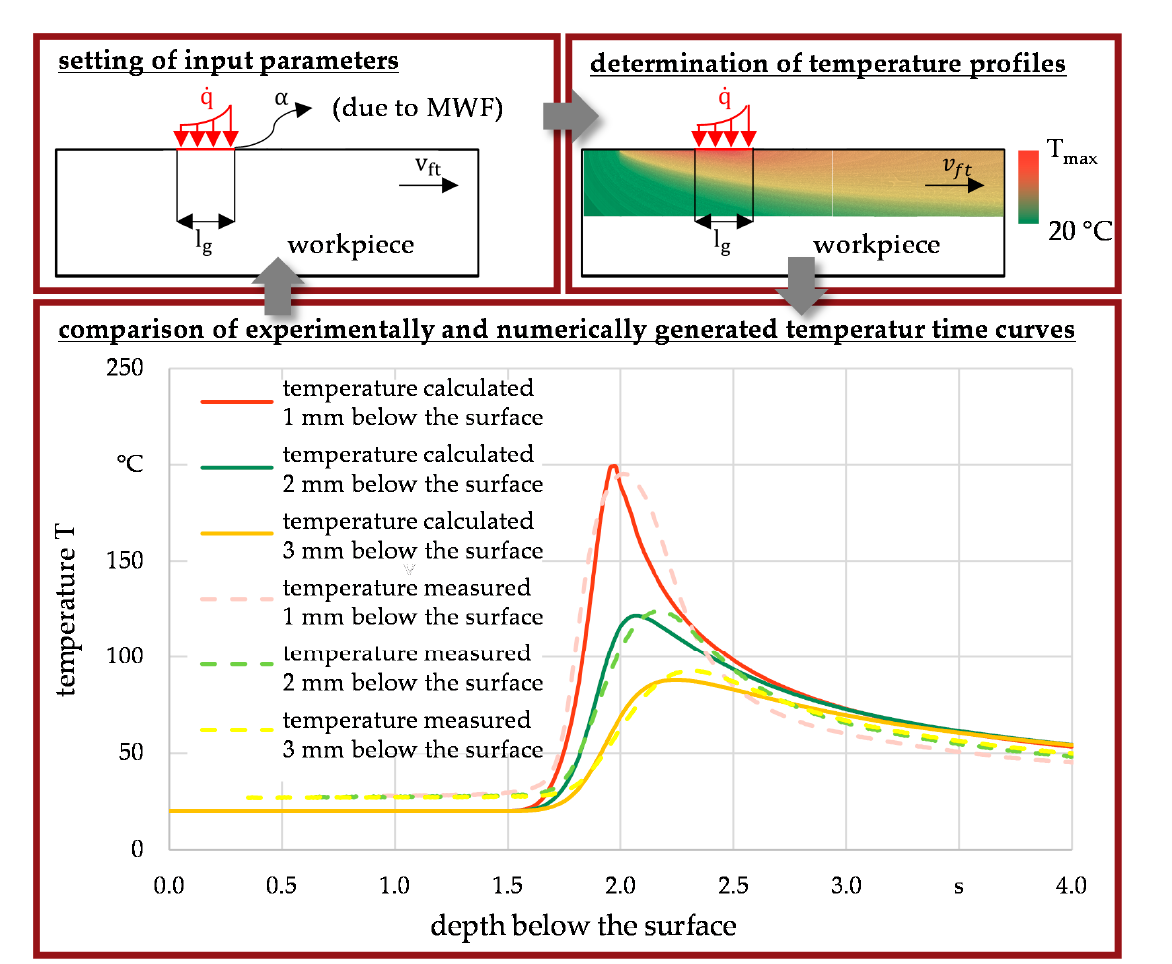
Figure 5. Procedure for validating the numerically generated data. The heat flux density and heat transfer coefficient were at first roughly estimated from power and process force measurements and also by data from literature [28,29] for every grinding setup. In additional steps, these quantities were adjusted and fine-tuned in the FE model in order to compensate deviations between experimentally measured and calculated temperature-time curves in depths of 1, 2, and 3 mm below the initial surface. The numerically determined temperature-time curves were consistent with the . experimental data for heat flux densities of q = 6.5–17.7 W/mm 2 and heat transfer co- efficients of α = 5000–60,000 W/(mm 2 · K), which are varied depending on the